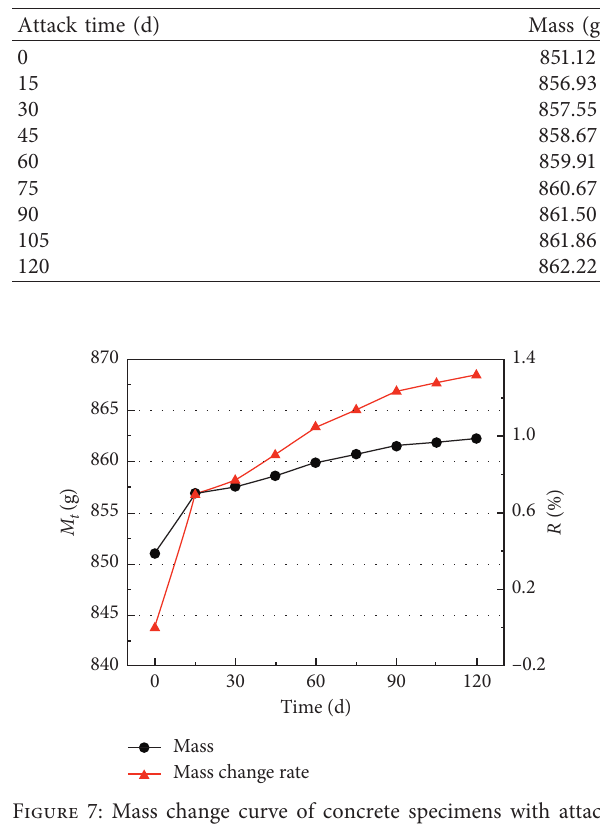
Figure 6: Surface crystallization, corners falling off, spalling, and cracking of concrete specimens. Table 6: Mass of concrete specimens at different attack times.